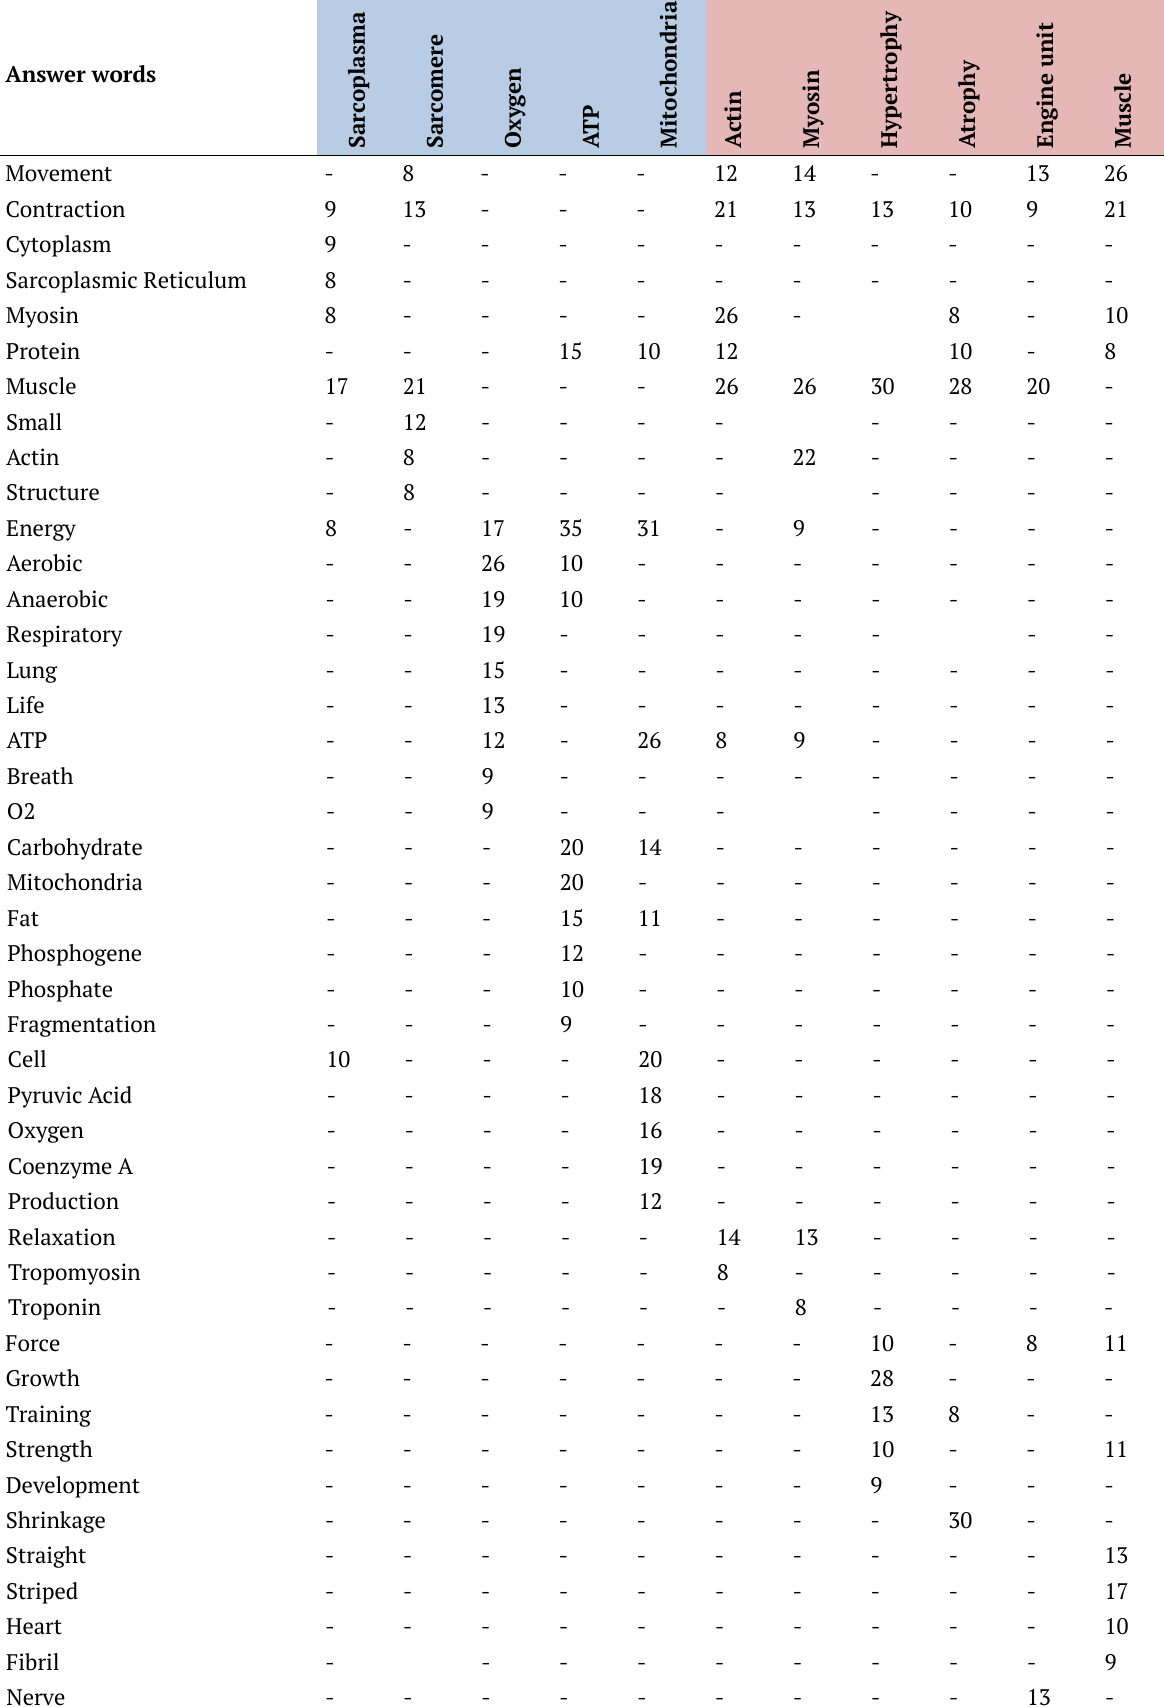
Table 1. Answer Words and Frequencies of Key Concepts Used as a